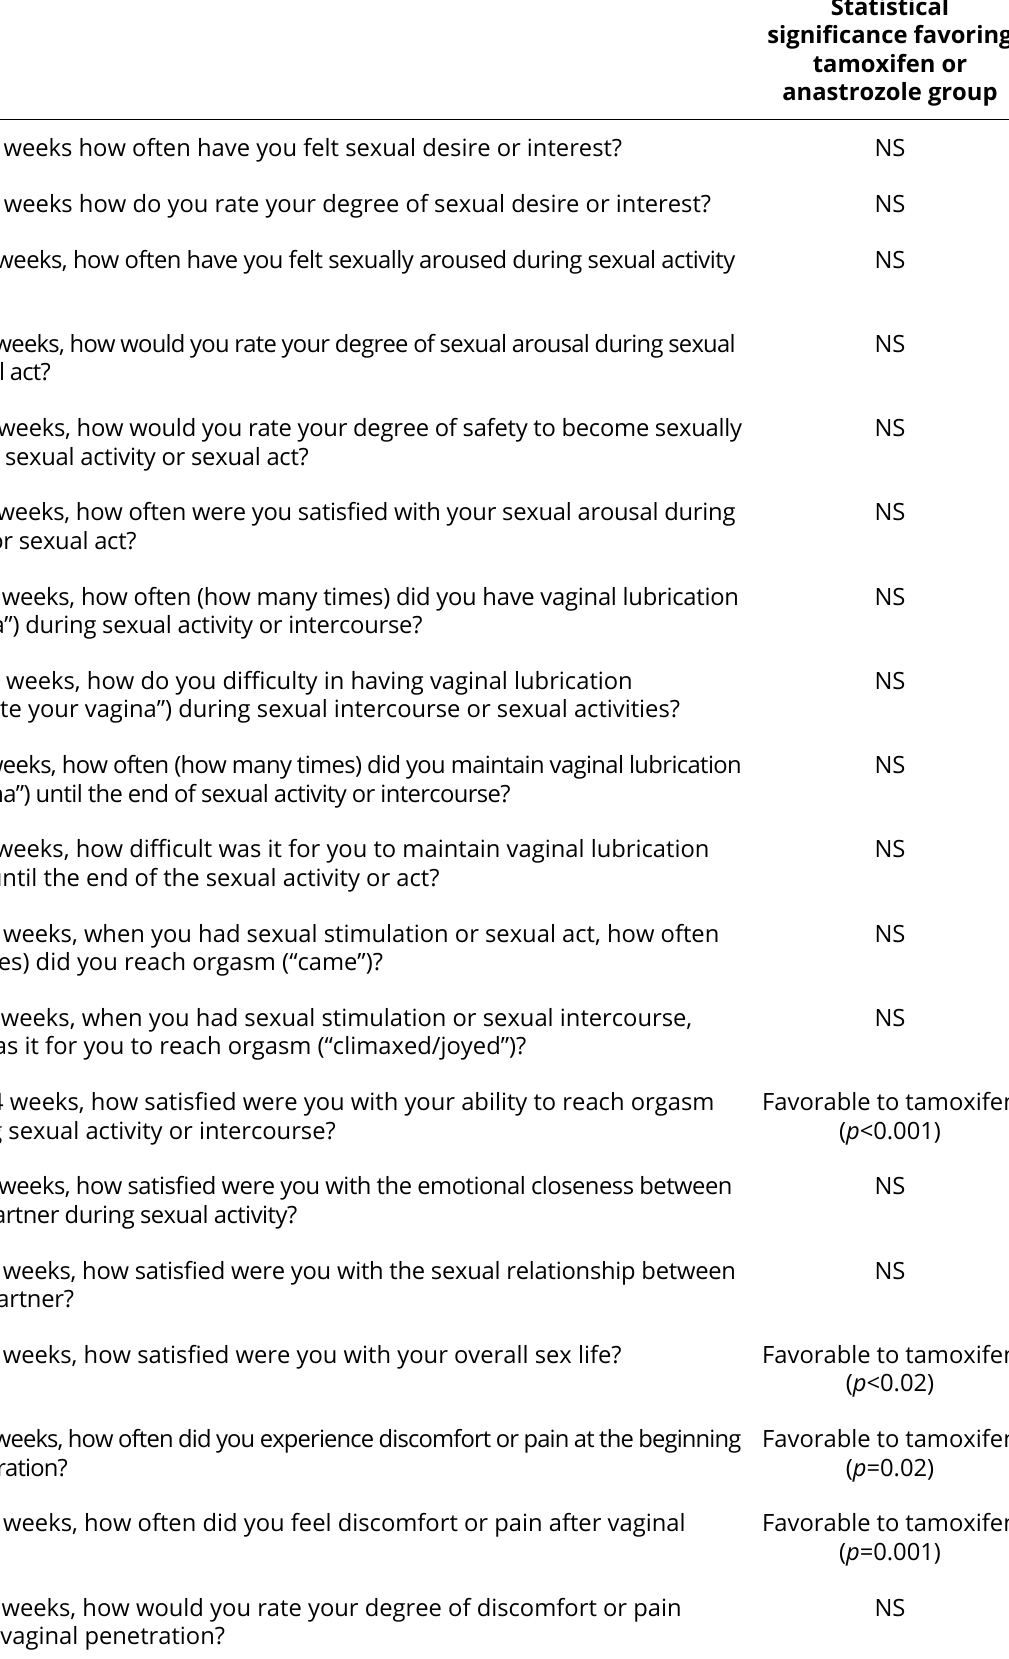
Table 2. FSDS-R instrument with its questions and levels of statistical significance for each of the questions.